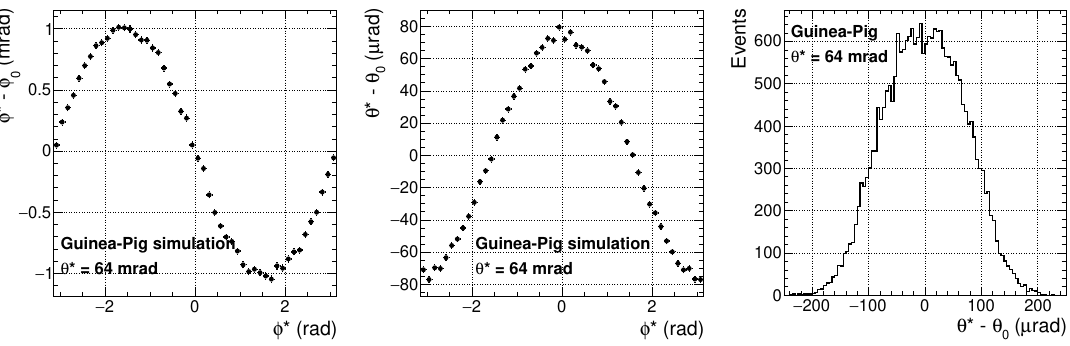
Figure 4 . Left: Average of the di(cid:11)erence between the e (cid:0) azimuthal angle after the beam-beam e(cid:11)ects in the initial state ( (cid:30) ) and the angle at the generator level ( (cid:30) (cid:3) ), as a function of the latter, 0 for 45 : 6 GeV electrons from leading-order Bhabha interactions, emitted at 64 mrad with respect to the electron beam direction. Middle: idem but for the e (cid:0) polar angle. Right: Distribution of the shift in polar angle induced by the beam-beam e(cid:11)ects in the initial state. duced by the beam-beam e(cid:11)ects in the initial state has a negligible e(cid:11)ect (a few 10 (cid:0) 6 ) on the